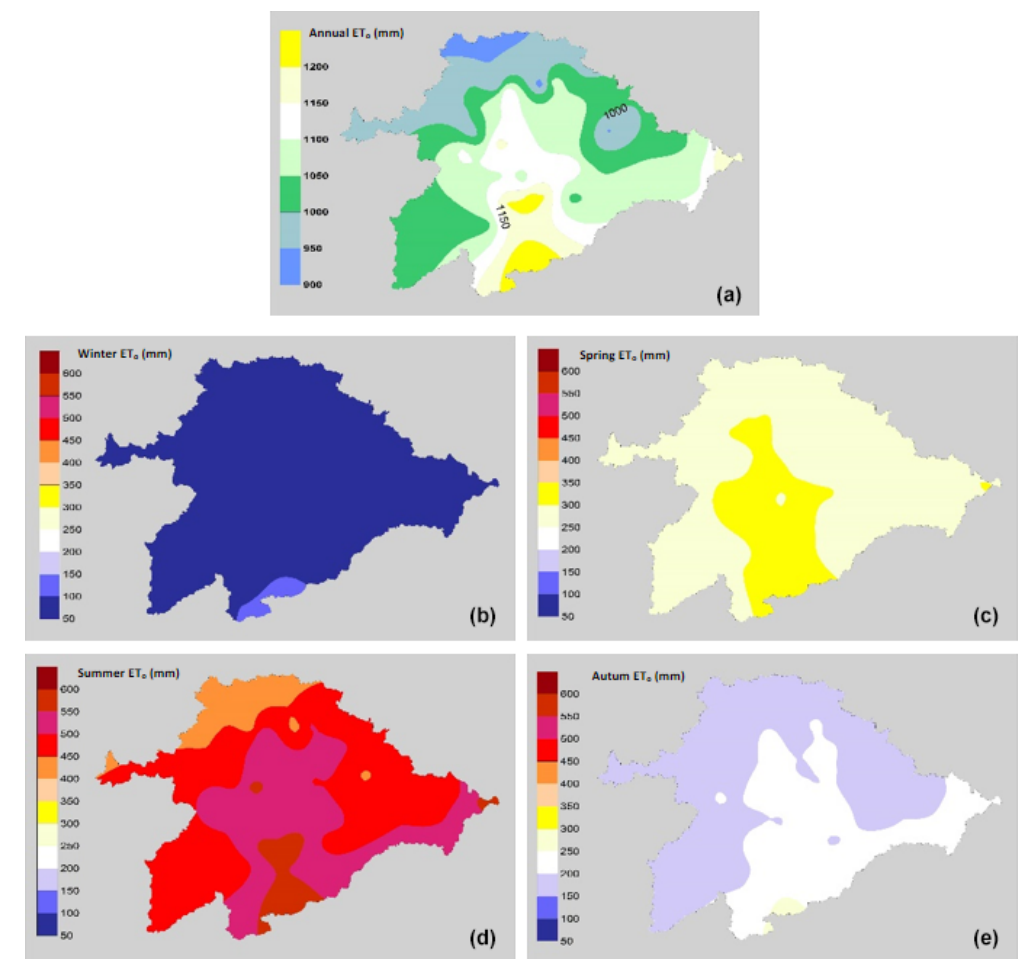
Figure 2. Mean values season of ET o (mm) during the study period 2000–2018. (a) Annual, (b) winter (December, January and February, or DJF), (c) spring (March, April and May, or MAM), (d) summer (June, July and August, or JJA) and (e) autumn (September, October and November, or